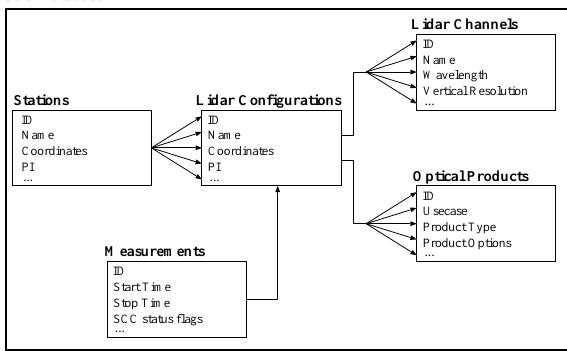
Figure 2. Simplified version of the SCC database structure. Mul- tiple arrows indicate one-to-many relationship while single arrows represent one-to-one